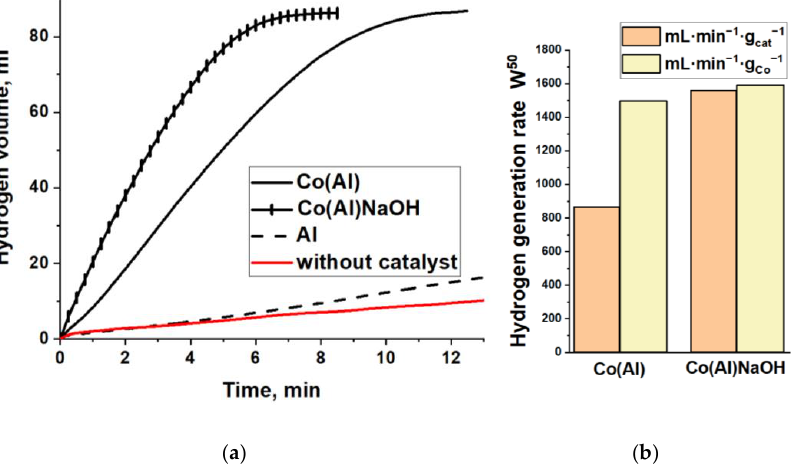
Figure 4. ( a ) Kinetic curves and ( b ) rate W 50 of hydrogen evolution during the hydrolysis of NaBH 4 without a catalyst and in the presence of Al, C о (Al), and C о (Al)NaOH. T = 40 °C. Elemental analysis confirmed that this NaOH treatment led to almost complete re- moval of Al from the sample. Its residual amount is 0.06 wt%. The content of cobalt in- creased from 57.8 to 98.1 wt%. XRD data also show that Co 0 (hcp) is the only crystalline phase of the C о (Al)NaOH sample (Figure 2a). Simultaneously, the value of SCR of Co decreases slightly from 15 to 12 nm (Table 1). As can be seen from the SEM images (Figure 3e – h), Co(Al)NaOH is composed of hollow particles of metallic cobalt in Co(Al) particle shapes. Some of the shells were destroyed under the action of rapidly released hydrogen. The high-magnification SEM images (Figure 3g,h) demonstrate that the C о (Al)NaOH sur- face is covered by small, close-packed plates. This lamellar morphology is characteristic of cobalt hydroxide Co(OH) 2 [62,63]. The study of the catalytic properties showed that the hydrogen-generation rate dur- ing the NaBH 4 hydrolysis in the presence of cobalt hollow spheres C о (Al)NaOH is 1.8 times higher than in the presence of the initial Co(Al) sample containing aluminum (Fig- ure 4a). However, the calculation of W 50 per cobalt mass in the catalyst shows similar val- ues for these samples (Figure 4b). Therefore, despite severely changing the morphology and chemical composition, NaOH treatment did not affect the activity normalized to the cobalt content. The hydrogen-generation rates obtained for C о (Al)NaOH, namely 1560 mL·min −1 ·g cat −1 at 40 °C, 920 mL·min −1 ·g cat − 1 at 30 °C, and 585 mL·min −1 ·g cat −1 at 25 °C, are within the ranges of values typically obtained for cobalt catalysts (Table S1). The apparent activation energy calculated using the Langmuir – Hinshelwood model was determined to be 55.5 ± 1.9 kJ·mol −1 (see the Supplementary Materials, Figure S5, Table S3). This value is close to the value of 63 kJ/mol, which was determined for hollow cobalt nanoparticles of